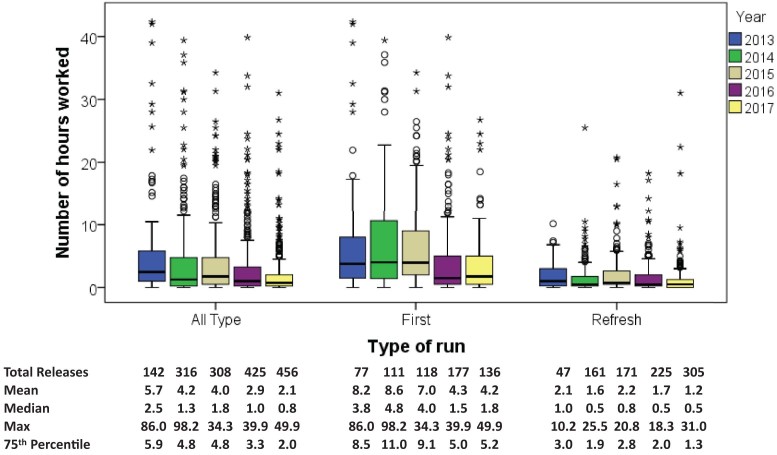
Efficiency of performing data releases. The dark line in the middle of the boxes is the median. The bottom of the box indicates the 25th percentile. The top of the box represents the 75th percentile. The whiskers extend to 1.5 times the height of the box. The points are outliers, circles being outliers lying between 1.5 and 3 times the height of the box, asterisks being extreme outliers lying >3 times the height of the box.